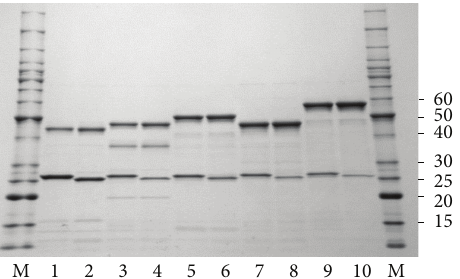
Figure 1: SDS-PAGE analyses of recombinant P. furiosus ACS isoenzymes. The lanes correspond to the following: 1: ACS1-G; 2: ACS1-A; 3: ACS2-G; 4: ACS2-A; 5: ACS3-G; 6: ACS3-A, 7: ACS4- G; 8: ACS4-A; 9: ACS5-G; and 10: ACS5-A. Each lane contains approximately 2 𝜇 g of the protein obtained after the heat-treatment step. Lanes M indicate molecular weight markers (given in